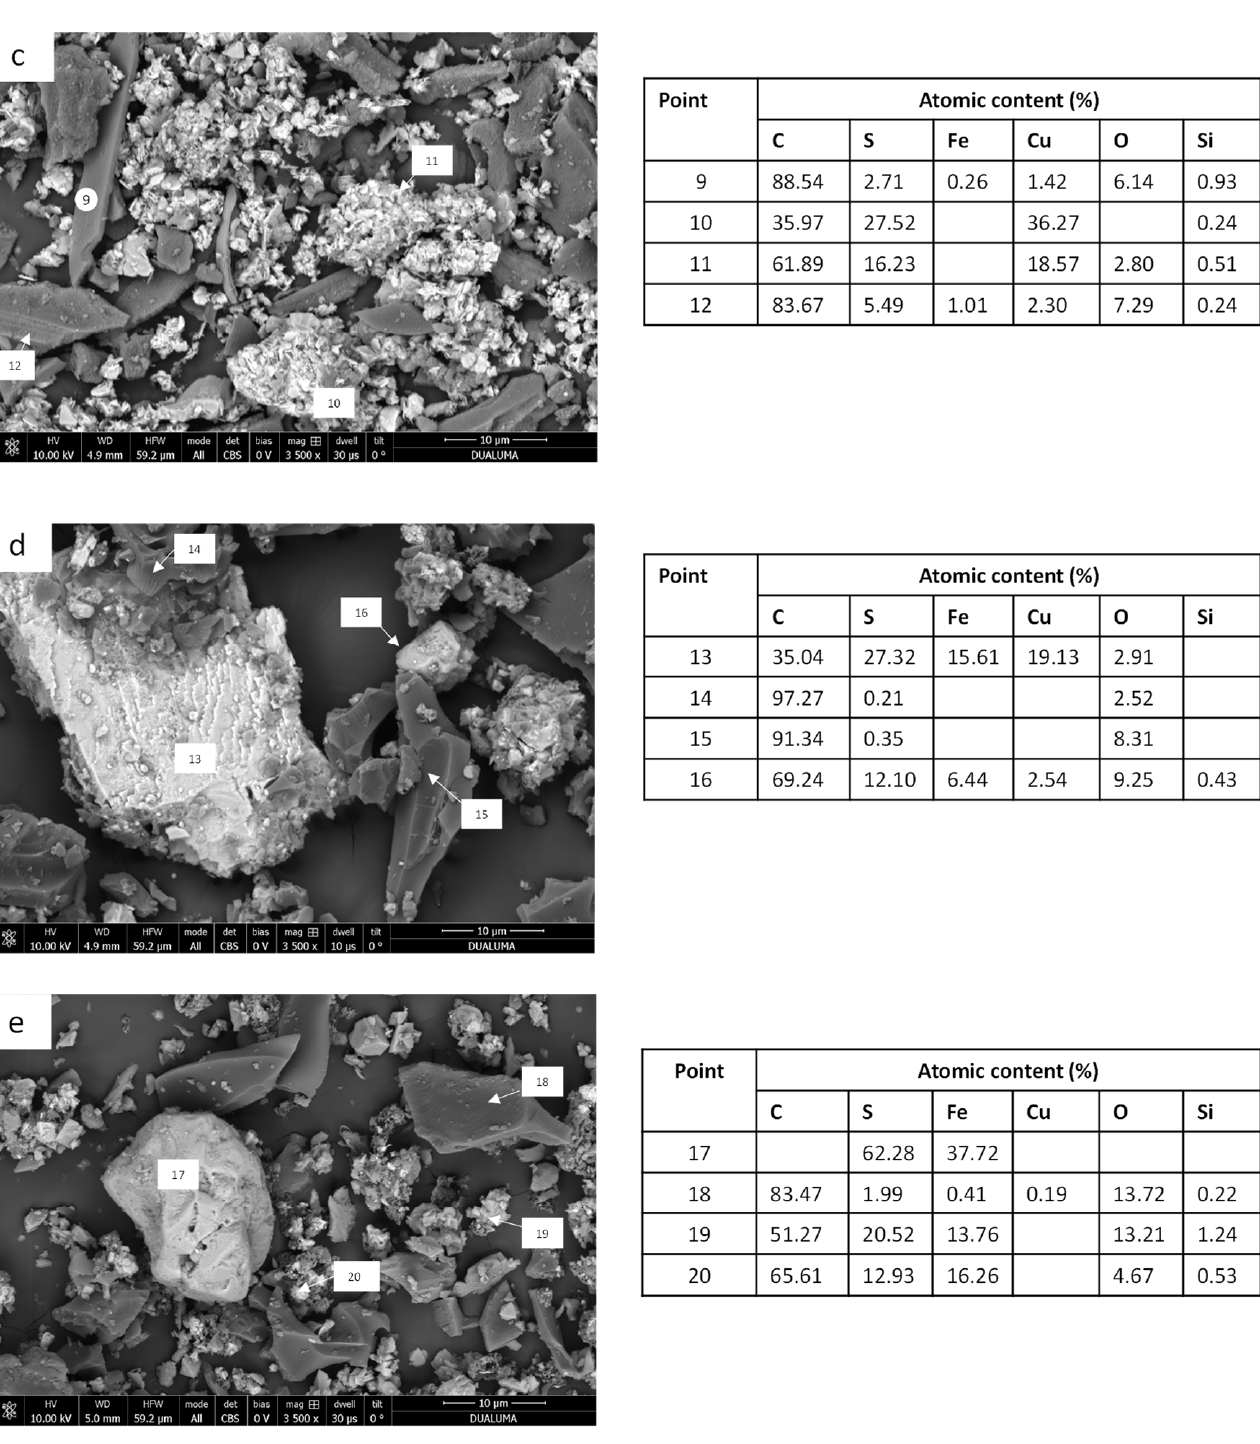
Figure 7. SEM-EDS images of final residues obtained after 96 h of leaching: ( a ) CPY; ( b ) CPY:CC 1:1; ( c ) CPY:CC 1:0.25; ( d ) (CPY:BC 1:1); ( e ) (CPY:BC 1:0.25) .